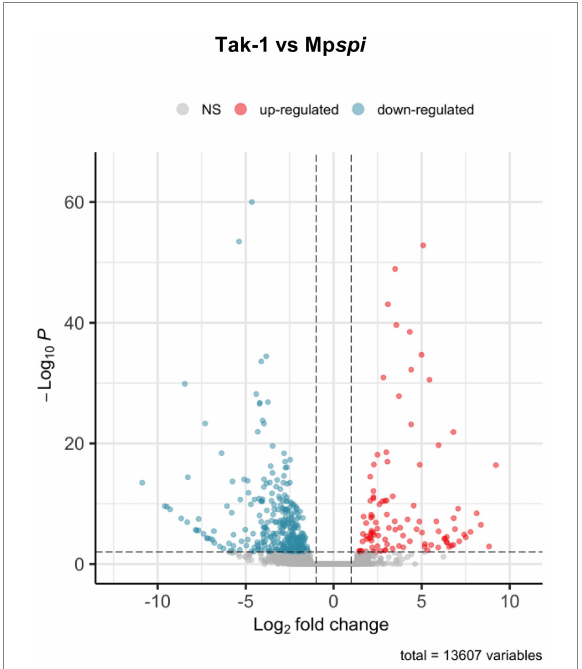
FIGURE 7 Volcano plot of differentially expressed genes between Tak-1 wild type and Mp spirrig . Data from three biological replicates per genotype. Of 20,574 expressed genes, 13,607 remained after quality filtering (> 10 reads across samples). Of these, 442 were differentially expressed at a threshold of 2-fold change (log2-fold change > 1; vertical dashed lines) at a significance level of 0.01 (horizontal dashed line). Of these, 104 showed higher expression (red) and 338 lower expression in Mp spirrig than in